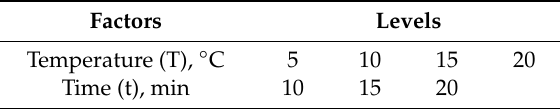
Table 1. Factors and levels of the experimental design.